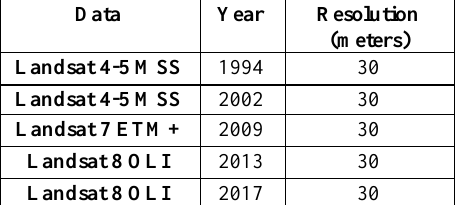
Figure 2: Methodology for mapping temporal change of